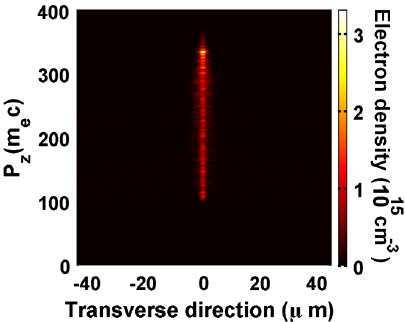
FIG. 8. Transverse position-longitudinal momentum phase space of the beam electrons after 18 mm of acceleration for a ¼ 3 : 5 (cid:4) 10 16 cm (cid:1) 3 , normalized vector poten- beam density, n b